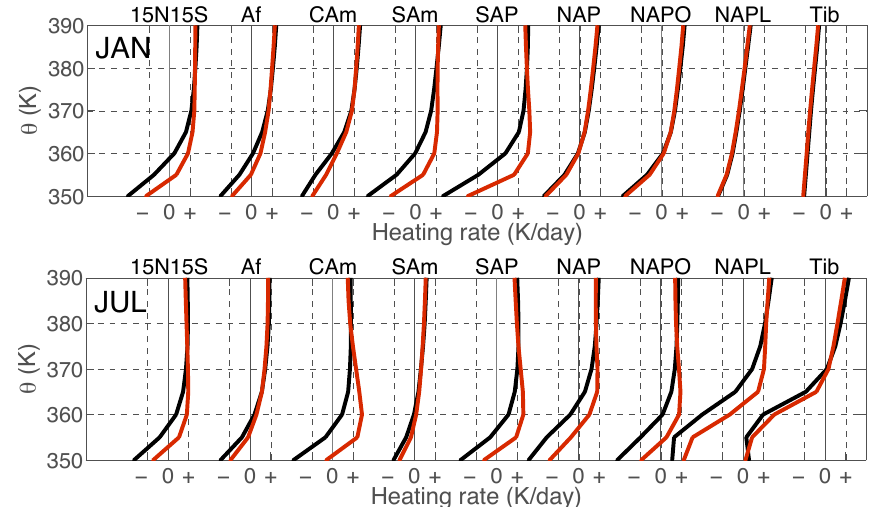
Fig. 2. Monthly mean radiative heating rates, represented as change in potential temperatures, calculated for January and July and both all-sky (in red) and clear-sky (in black) conditions, using the ERA-Interim dataset for 2005. The vertical profiles are obtained over the 15 ◦ S–15 ◦ N latitude band as well as 8 other geographical regions. Africa (Af): (15 ◦ S–20 ◦ N) × (40 ◦ W–20 ◦ E); C. America (CAm): (0 ◦ – 20 ◦ N) × (110 ◦ W–60 ◦ W); S. America (SAm): (35 ◦ S–0 ◦ ) × (75 ◦ W–45 ◦ W); S. Asian-Pacific (SAP): (20 ◦ S–10 ◦ N) × (70 ◦ E–120 ◦ W); N. Asian-Pacific (NAP): (10 ◦ N–35 ◦ N) × (70 ◦ E–120 ◦ W); N. Asian-Pacific Land (NAPL): (20 ◦ N–35 ◦ N) × (70 ◦ E–120 ◦ E); N. Asian-Pacific Ocean (NAPO): NAP-NAPL; Tibetan plateau (Tib): (30 ◦ N–35 ◦ N) × (80 ◦ E–95 ◦ E). The “+” and “ − ” signs on the horizontal axis respec- tively stand for +1 and − 1Kday − 1 . The shift between two successive profiles is 4Kday − 1